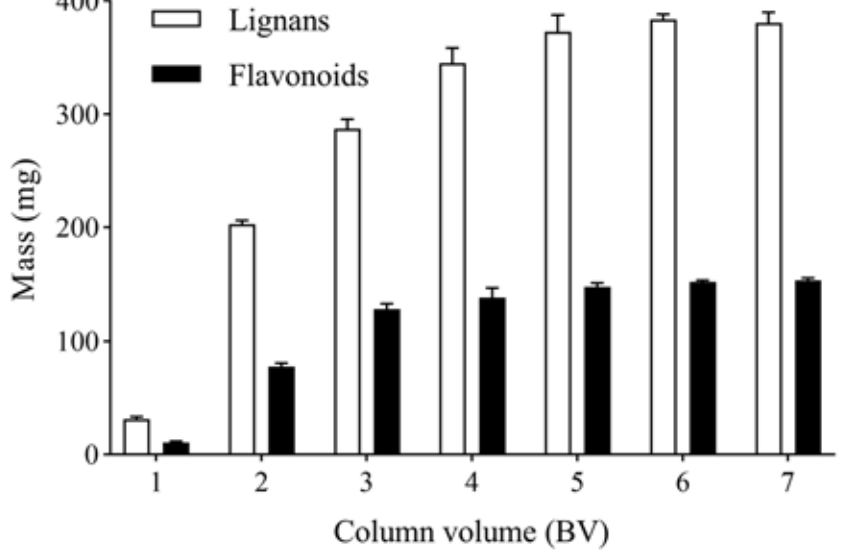
Figure 6. Effect of eluent volume on the mass of total lignans and flavonoids in P ‐ TLF.